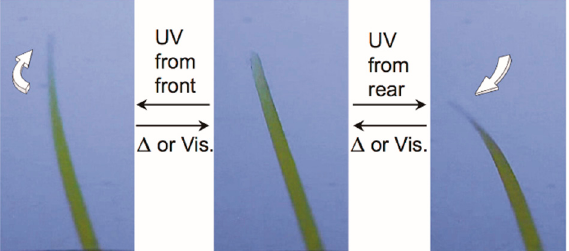
Figure 6. Photomechanical reversible bending with twisting of a chiral azobenzene crystal of trans -( S )- 11 . Upon UV irradiation on the front (001) face, the thin crystal bends with a left-handed twist. Bending in the same direction as the twist was seen upon light irradiation on the back (00-1) face. Reprinted with permission from [38]. Copyright 2016 Wiley-VCH.